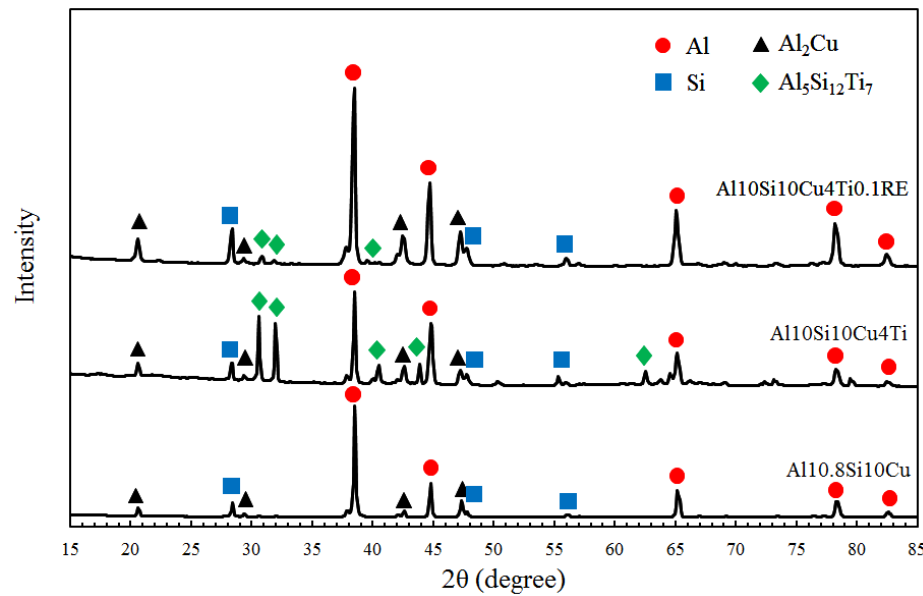
Figure 3. XRD analysis of the Al10.8Si10Cu, Al10Si10Cu4Ti and Al10Si10Cu4Ti0.1RE filler metals.